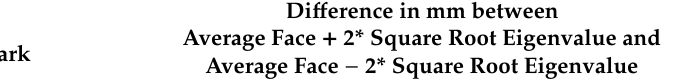
Table 3. Di ff erences in each landmark due to maternal smoking level PC2. These results should be interpreted with caution at this stage. They should be taken as a suggestion of which landmarks are likely to vary due to maternal smoking rather than providing exact